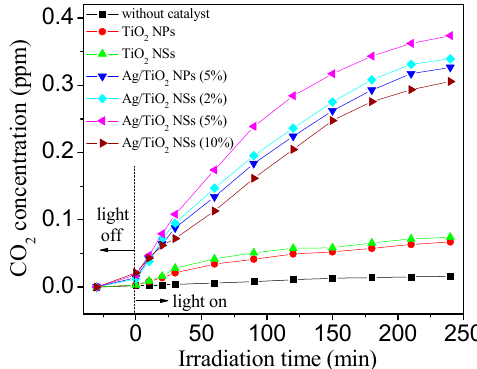
Figure 10. The changes of CO 2 concentration during HCHO photocatalytic degradation by different catalysts.